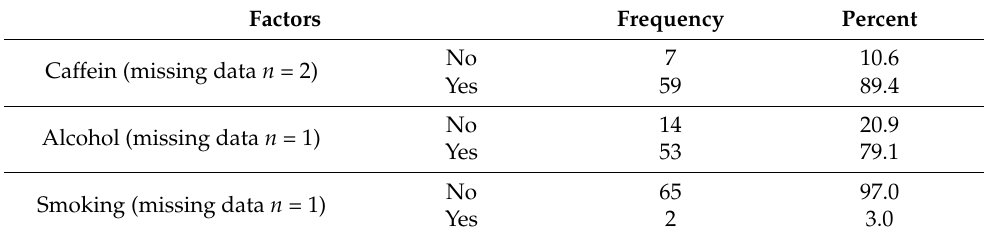
Table A3. Lifestyle information.